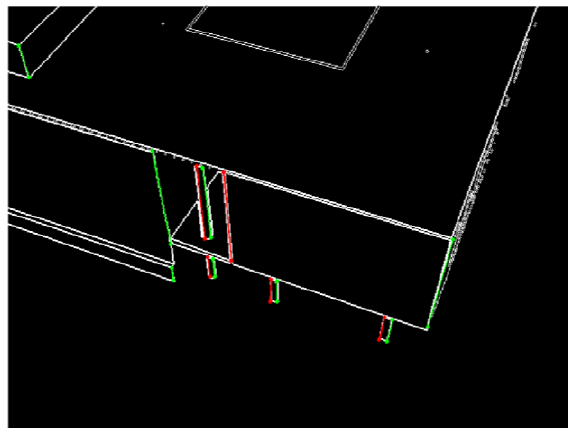
Figure 9. Left (red) and Right (green) Vertical Line Features overlayed on the synthetic image Using the same method, the Vertical Line Features were extracted from the 3D model offline. The model‟s vertices were classified according to corner type, and vertical edges were classified as either Left or Right Vertical Lines. Figure 9 shows the Left Vertical Line Features (red) and Right Vertical Line Features (green) that are visible in the synthetic image.